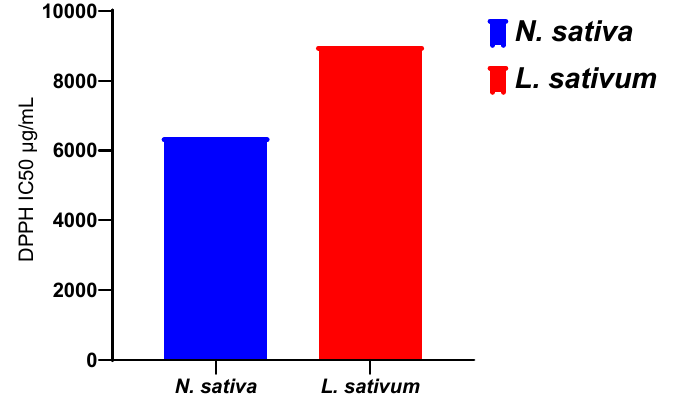
Figure 4. The scavenging free radical activity of vegetal of seeds of N. sativa and L. sativum .